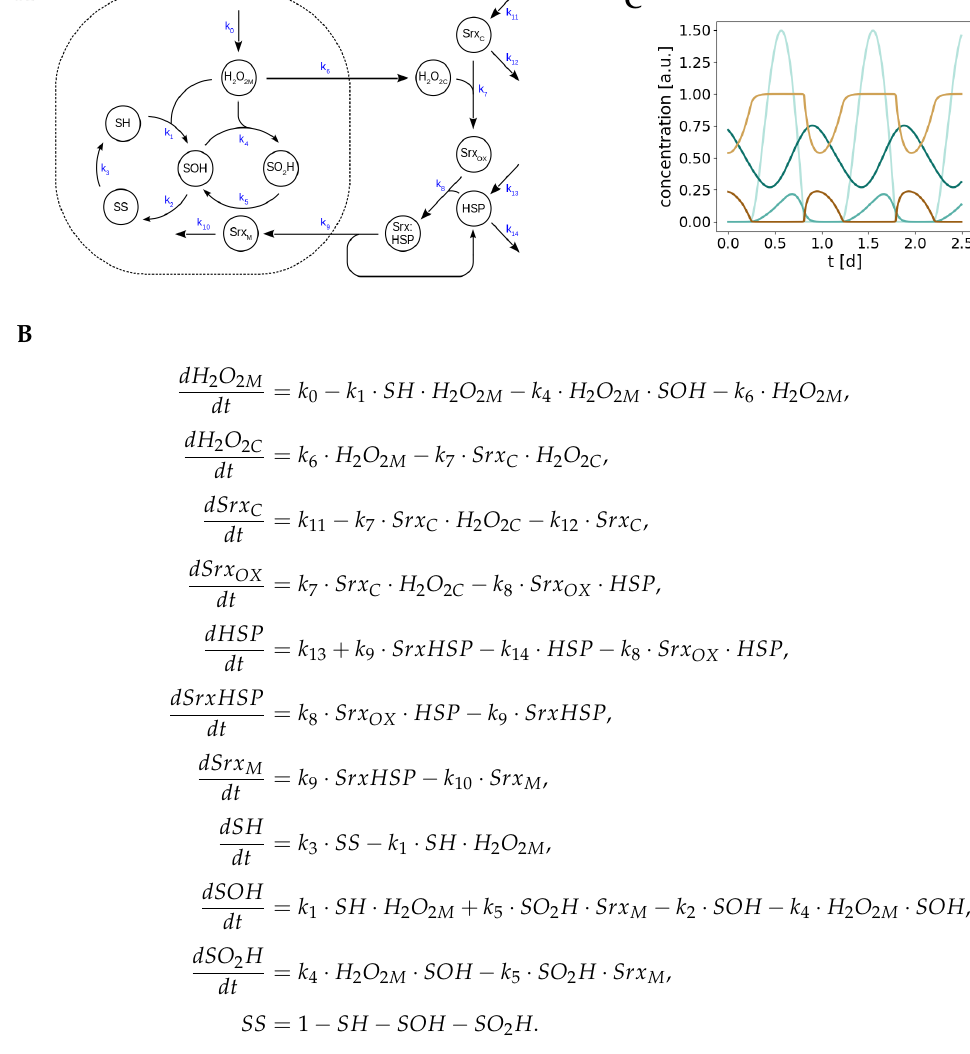
Figure A1. Detailed 10-ordinary differential equation (ODE) model for circadian redox oscillations. ( A ) Scheme of the biochemical species identified in the mitochondrial Prx3-SO 2 H/Srx circadian oscillating system. ( B ) Equations of the model. ( C ) Limit cycle oscillations obtained by numerical integration of the equations shown in ( B ) for the following parameter values (a.u.): k 0 = 1, k 1 = 10 7 , k 2 = 1, k 3 = 1, k 4 = 10 4 , k 5 = 2, k 6 = 0.2, k 7 = 2, k 8 = 0.5, k 9 = 0.2, k 10 = 0.2, k 11 = 0.2, k 12 = 0.1, k 13 = 0.2, k 14 = 0.1. The period of oscillation is 23.5h; the phase shift between Prx3-SO 2 H and mitochondrial Srx is